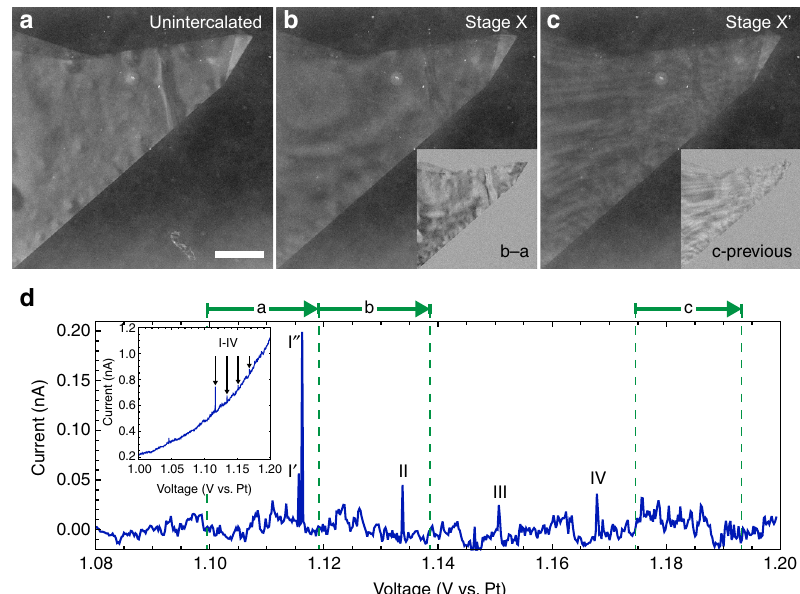
Fig. 6 STEM contrast evolution with decreasing stage number. a – c ADF STEM images of unintercalated ( a ), stage X ( b ), and stage X ′ < X ( c ) graphite. The insets are calculated difference images between the displayed and its preceding frame. d Background-subtracted current vs. voltage. Individual intercalation events are labeled I – IV. Events I ′ and I ″ , referred to collectively as event I in the text, occur 60 ms apart (equivalent to 15 STEM pixel rows). The voltage range over which images a – c are acquired is indicated by the green arrows. The inset shows the current-voltage data before subtraction. (For a discussion of the small peak just below 1.05 V see Supplementary Fig. 5b.) See Supplementary Movie 4. The scale bar is 1 μ